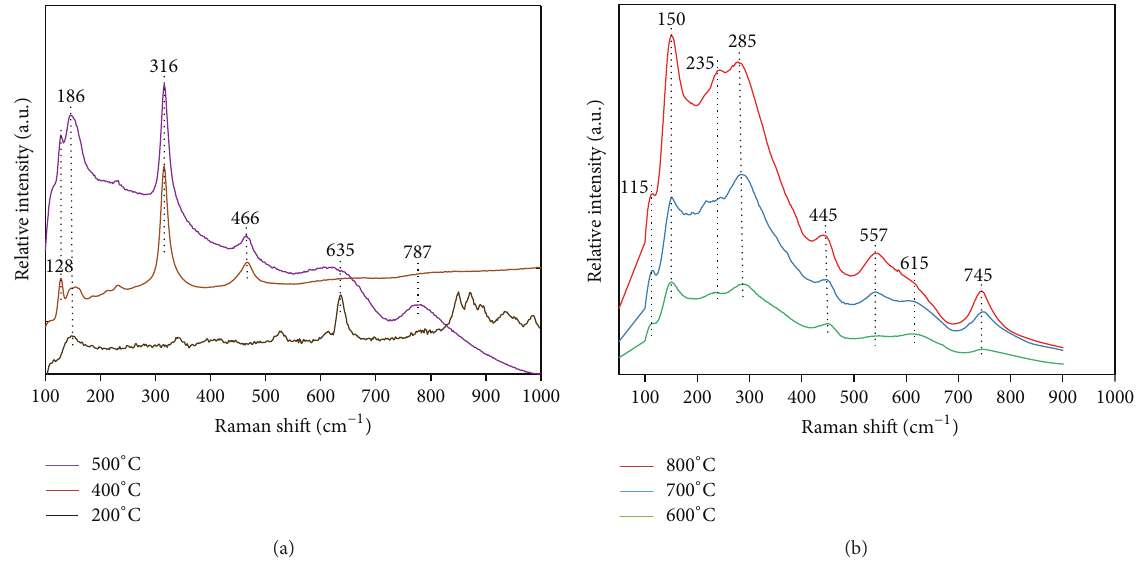
Figure 7: Raman spectra of samples prepared at various temperatures.